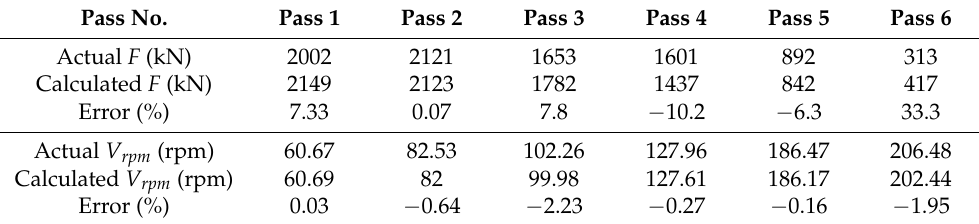
Table 3. Comparisons of the calculated roll force and roll speed with the actual data. Pass